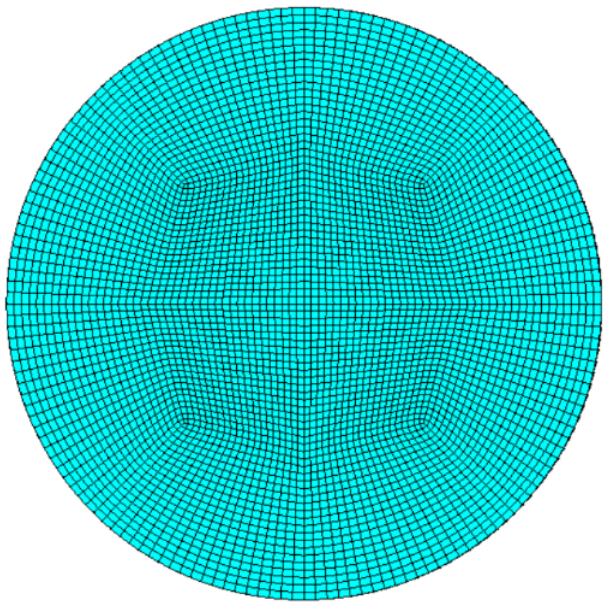
Figure 13. FE mesh detail: ( a ) common FE, ( b ) multilayer FE.